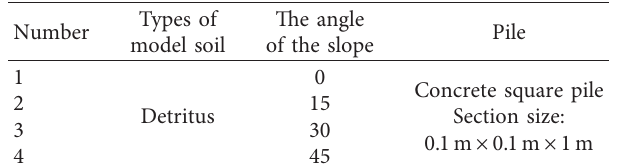
Table 1: Test scheme.